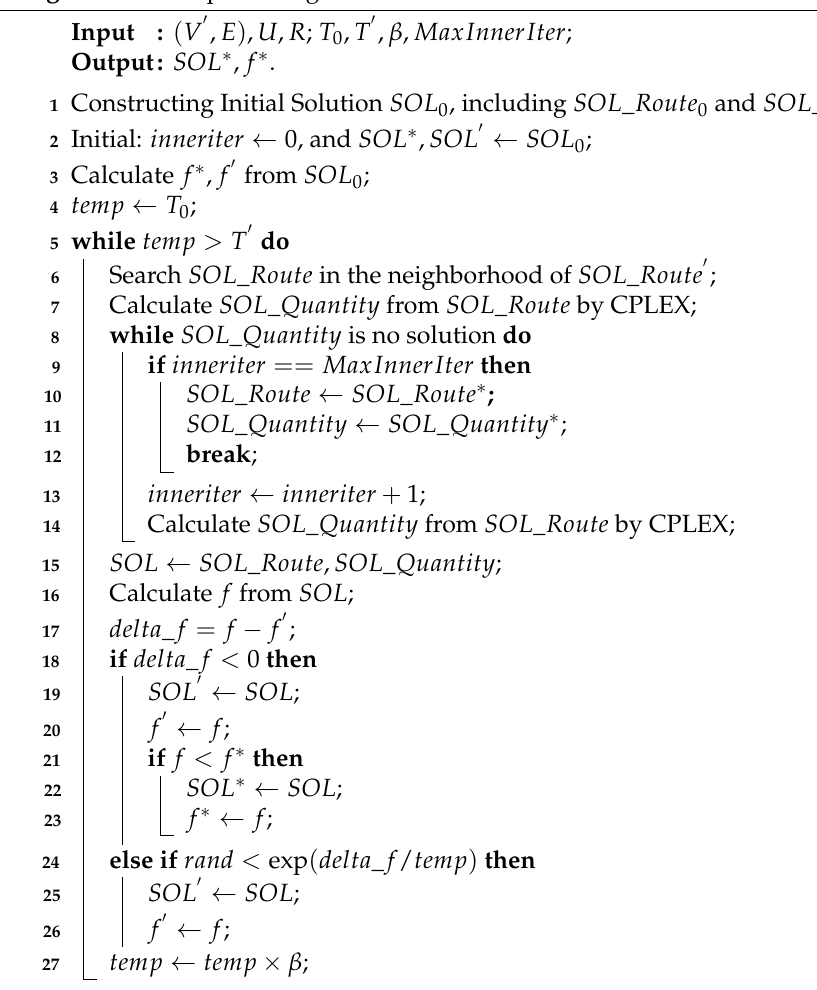
Algorithm 1: Proposed